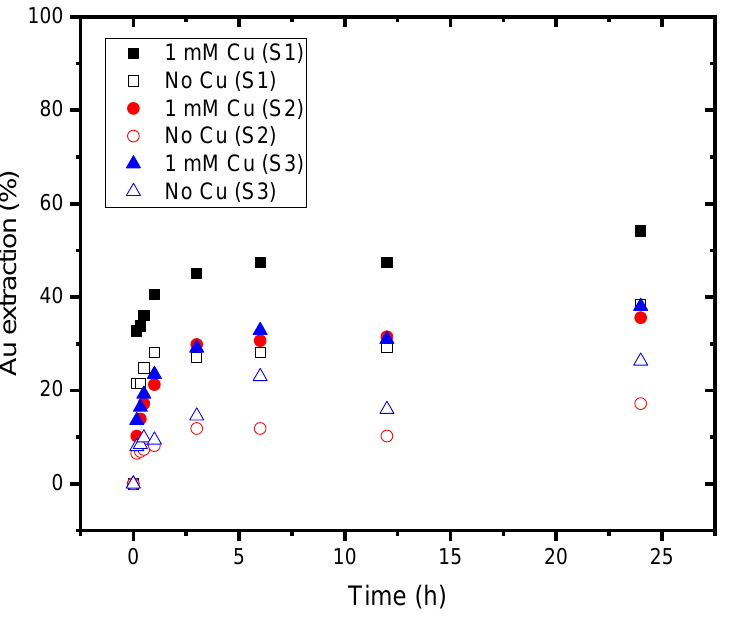
Figure 16. Effect of Cu(II) presence on gold extraction for Sample 1 (S1), Sample 2 (S2), and Sample (S3) at 0.5 M (NH 4 ) 2 S 2 O 3 and 0.5 M NH 3 (30% solids, − 300 + 150 µ m PSD, 26 ◦ 3 (S3) at 0.5 M (NH 4 ) 2 S 2 O 3 and 0.5 M NH 3 (30% solids, −300 + 150 µm PSD, 26 °C).